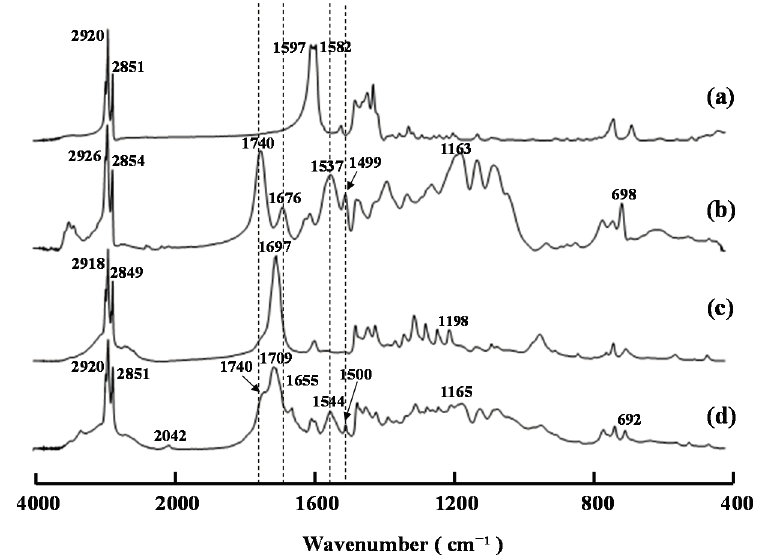
Figure 8. FT-IR spectra of (a) compound 5 ; (b) compound 4 ; (c) film A before the heating treatment; and (d) film A after the heating